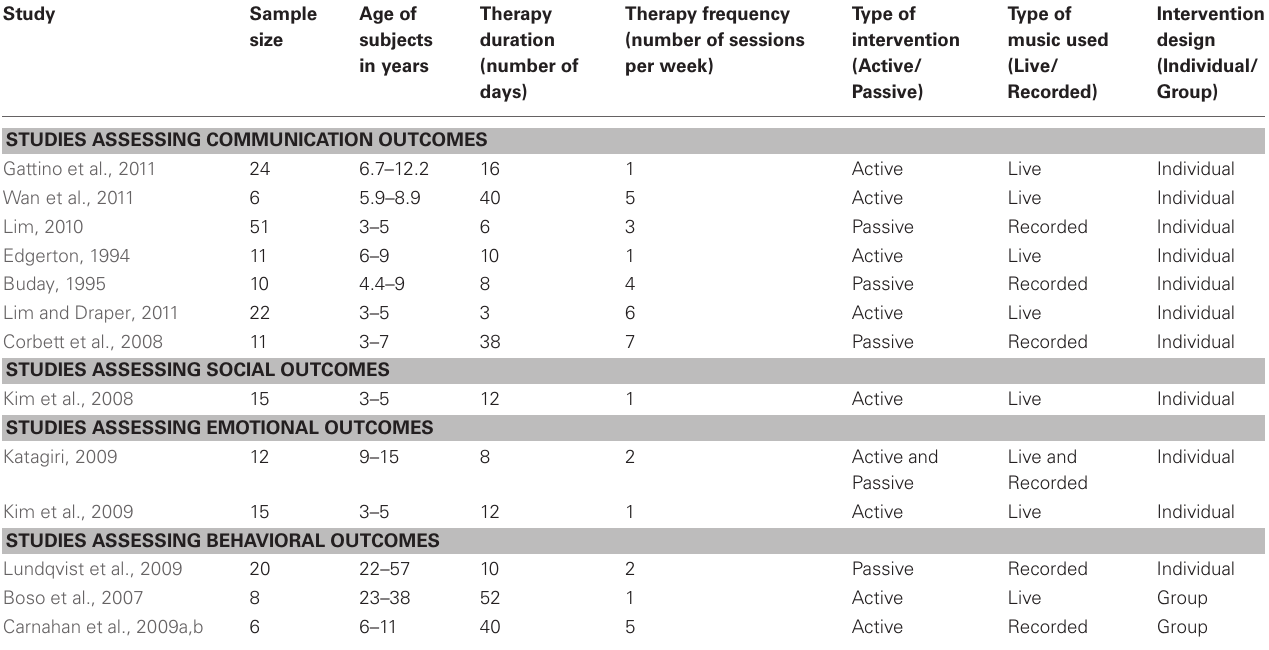
Table 1 | Music therapies in children with Autism Spectrum Disorders